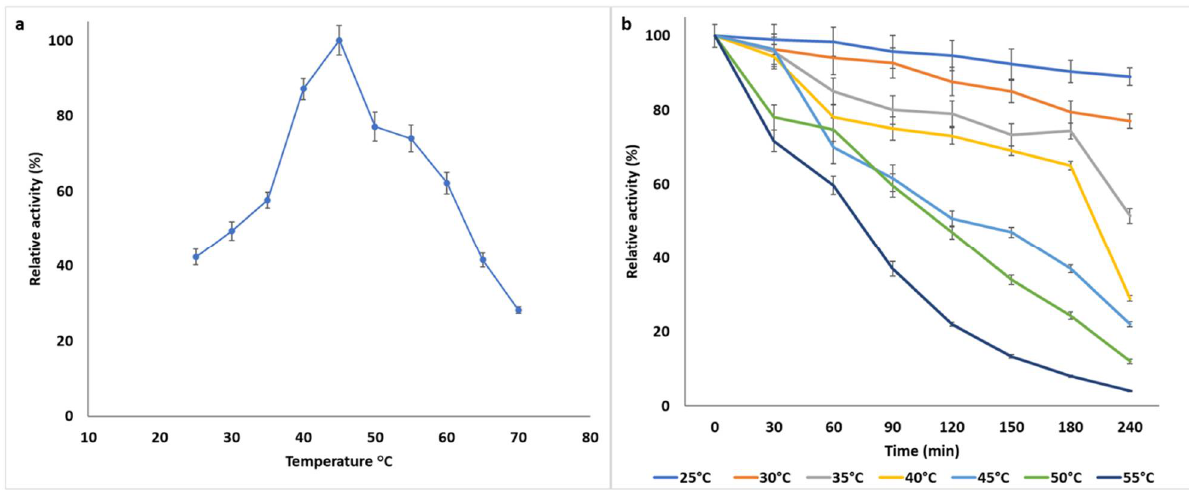
Figure 3. ( a ) Effect of temperature on the activity of Beauveria bassiana SAN01 xylanase; ( b ) Effect on temperature on the stability of Beauveria bassiana SAN01 xylanase: each point represents the mean ( n = 3) ± SD.